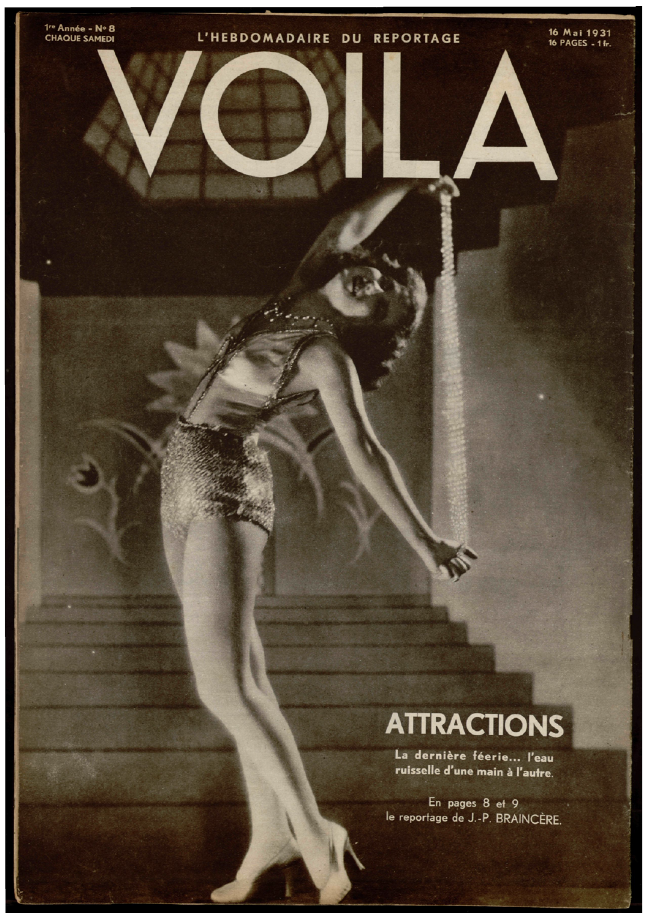
Couverture verso de Voilà , no. 8 (16 mai 1931), © Musée Nicéphore Niépce, ville de